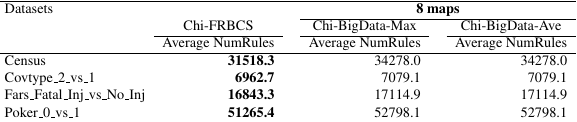
Table 6. Average number of rules generated for the Chi-FRBCS versions Datasets